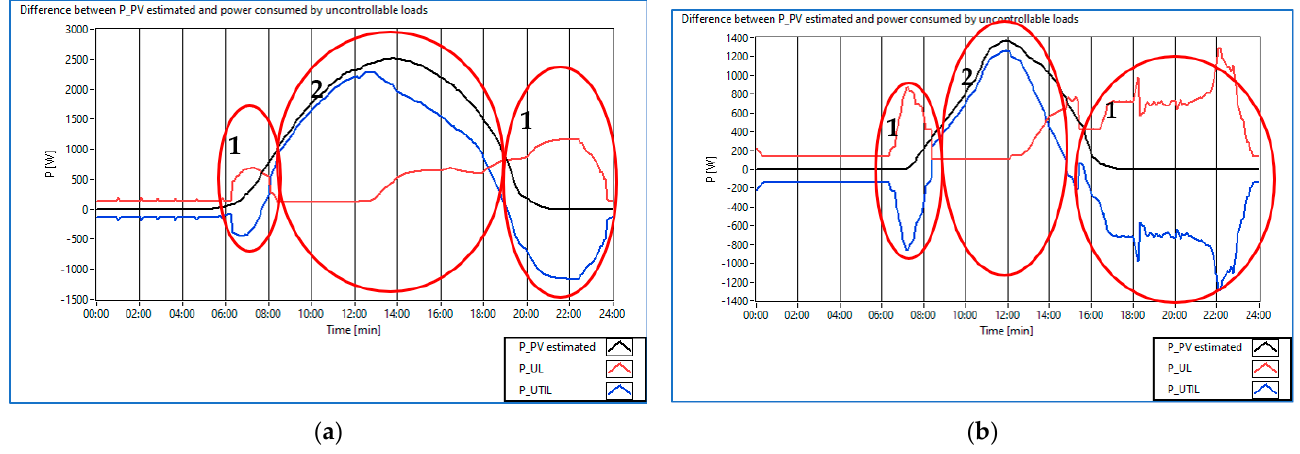
Figure 11. Scheduling for load-shifting optimization for: ( a ) scenario 1; ( b ) scenario 2.